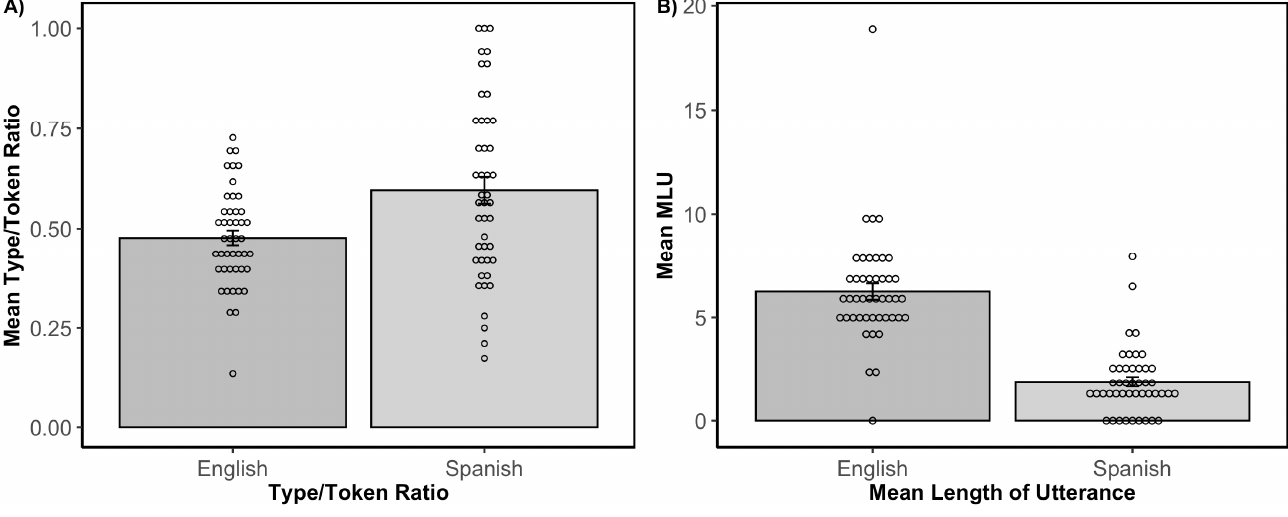
Figure 2. Mean (and standard error of the mean) for ( A ) Type/Token ratio and ( B ) MLU for English and Spanish within picture books in our sample. Dots represent individual picture